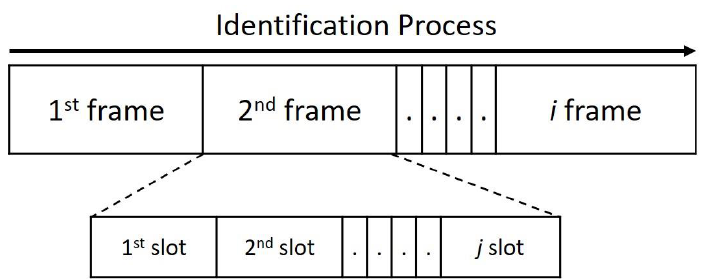
Figure 1. Relationship between frame and time slot.